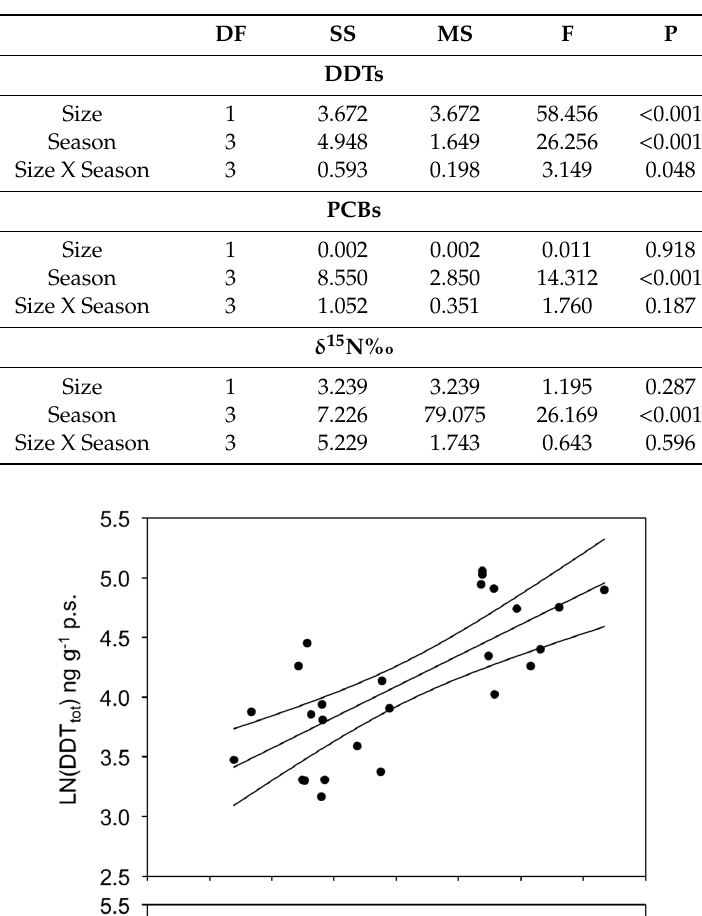
Table 1. Results of the two-way ANOVA tests performed on DDTsPCBs concentrations and δ 15 N% (cid:24)